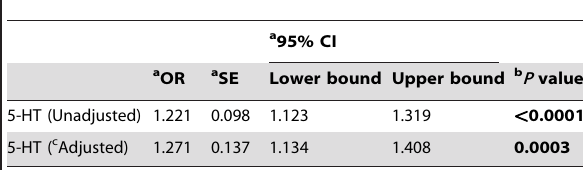
Table 2. Association between plasma levels of 5-HT and COPD in ever smokers with or without COPD by binary logistic regression analysis.